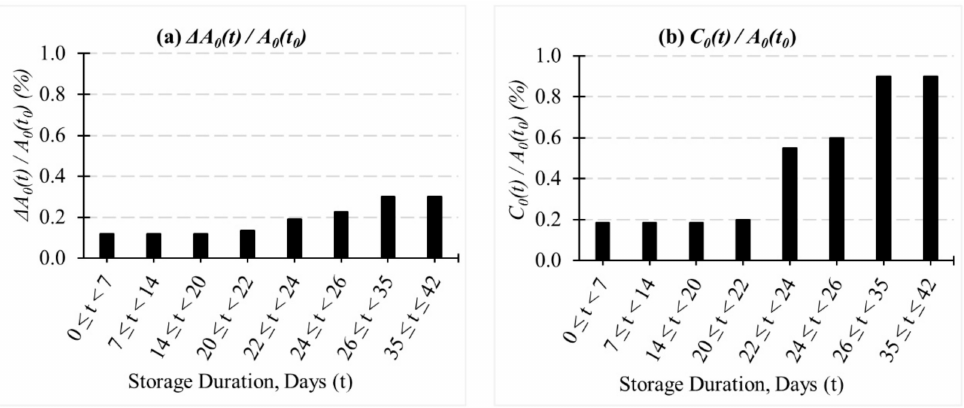
Figure 4. The evolution of the CG-RBC membrane model predicted a ( a ) reference bilayer-leaflet-area- di ff erence ( ∆ A 0 ( t ) ), and ( b ) reference total-membrane-curvature ( C 0 ( t ) ) during in-vitro RBC